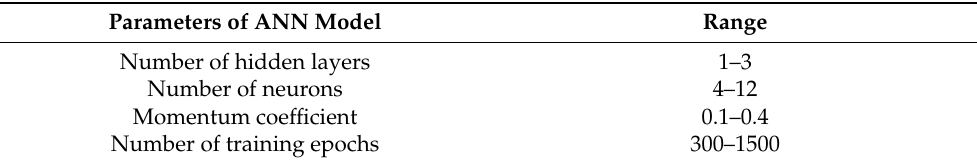
Table 3. Configurations of ANN